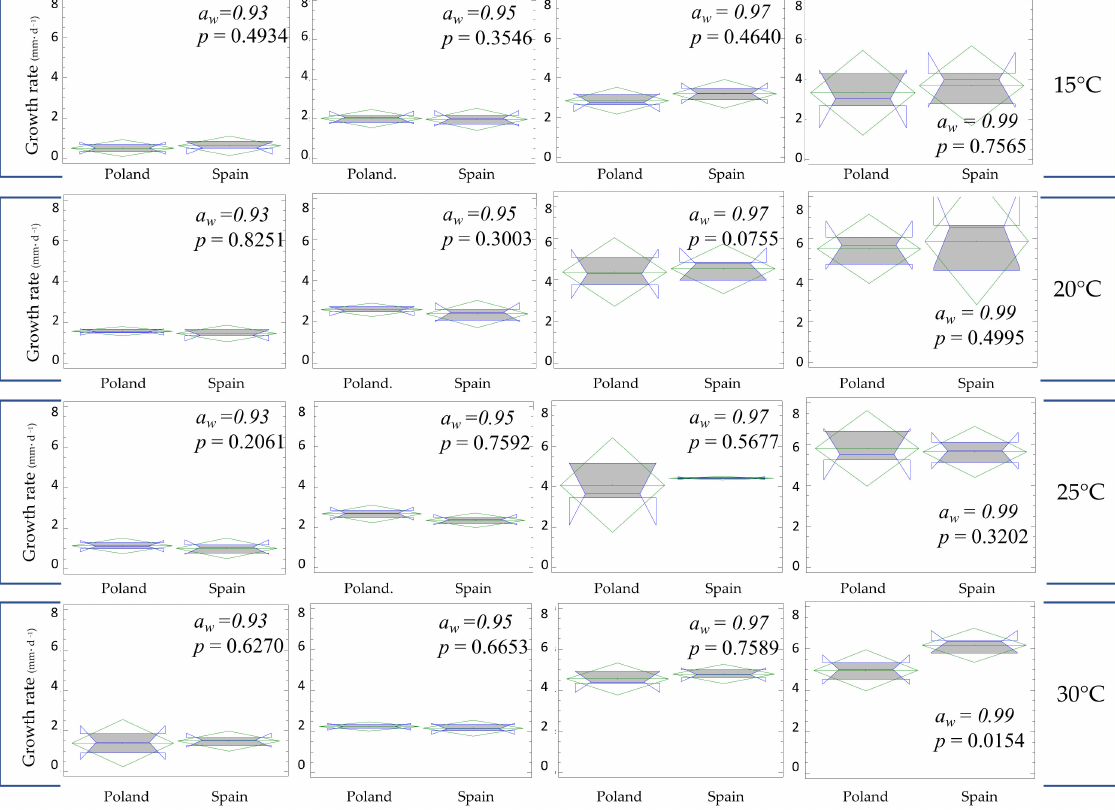
Figure 3. Box plots showing mycelial growth rate of Fusarium oxysporum associated with vascular wilt on asparagus at different regimes of temperature and water activity (a w ) depending on the cultivation region. The right of the box is the 75th percentile; the left is the 25th percentile; and the whiskers represent the maximum and minimum